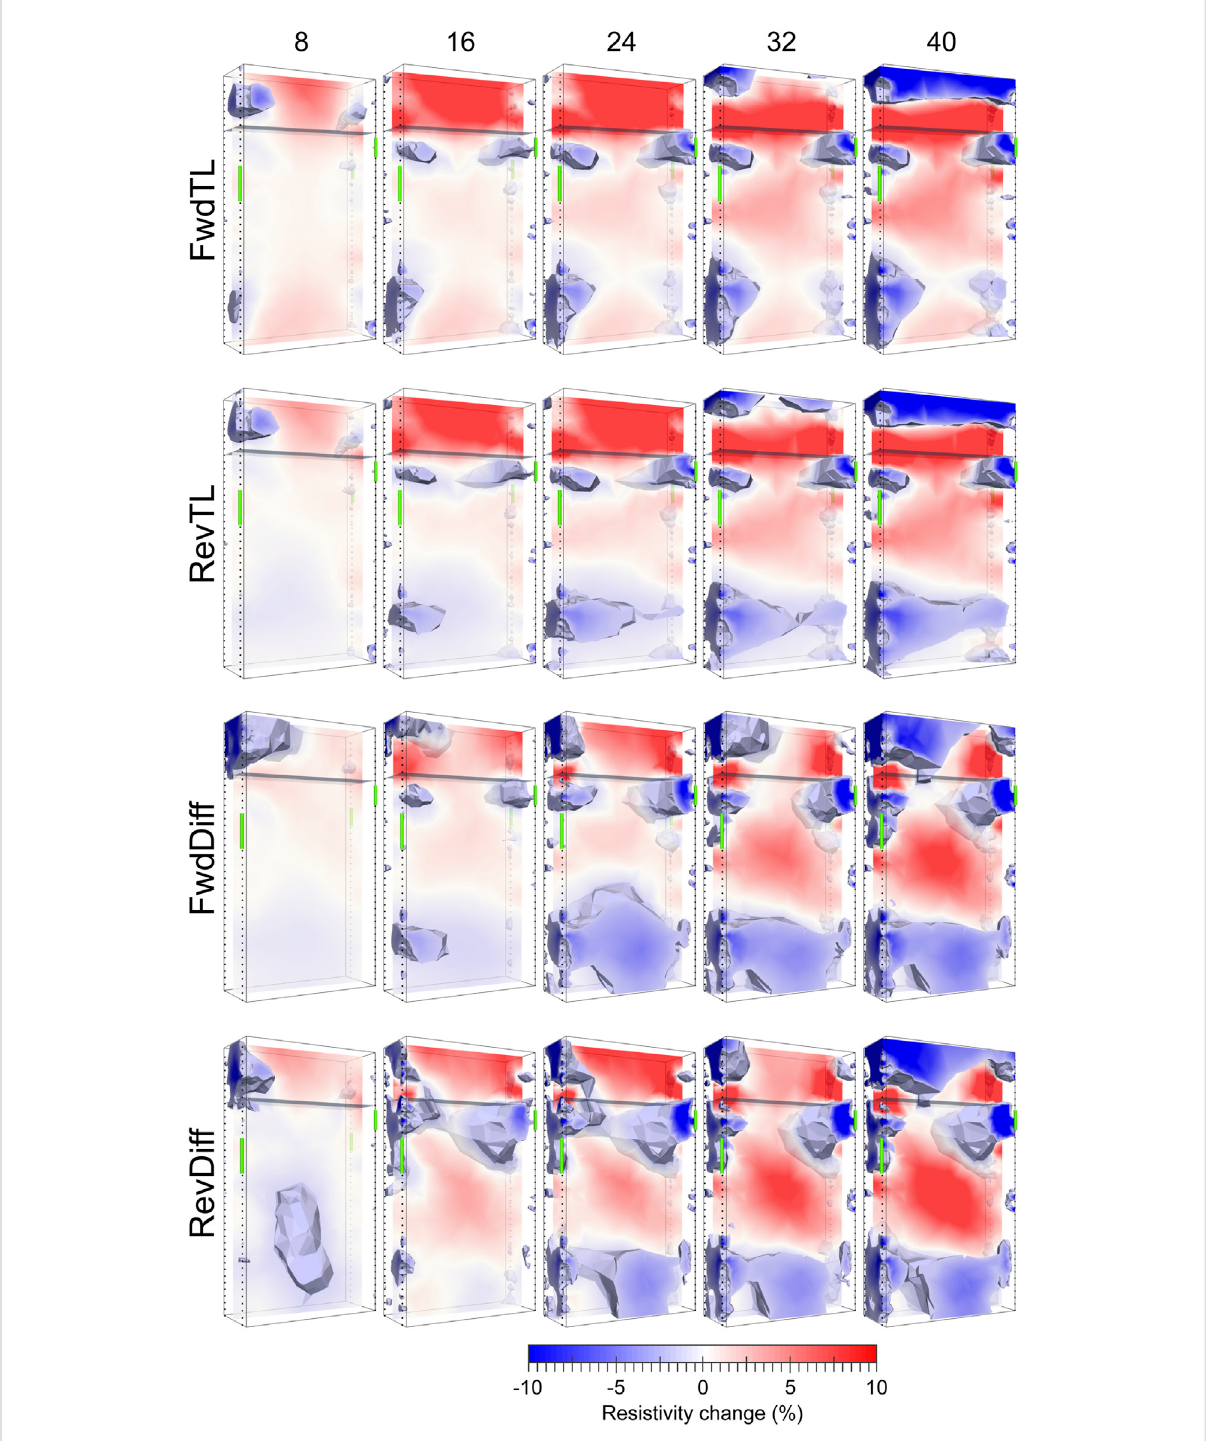
FIGURE 9 Distributionsof fractional resistivitychange atMSSS for the forward and reverse time-lapse and difference inversions at thetimesteps indicated at the top of the diagram. Isosurfaces indicate resistivity changes of < − 2%. Green cylinders show regions of historic contamination (data © Sella fi eld